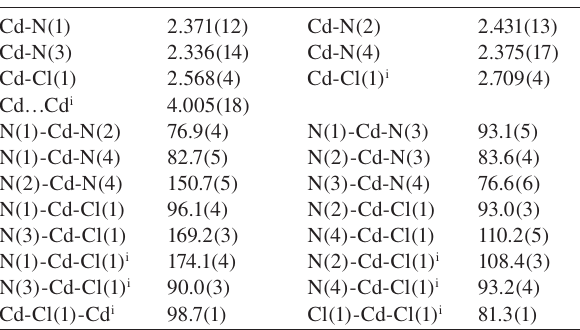
· 2ClO ( 1 ) with the 2 4